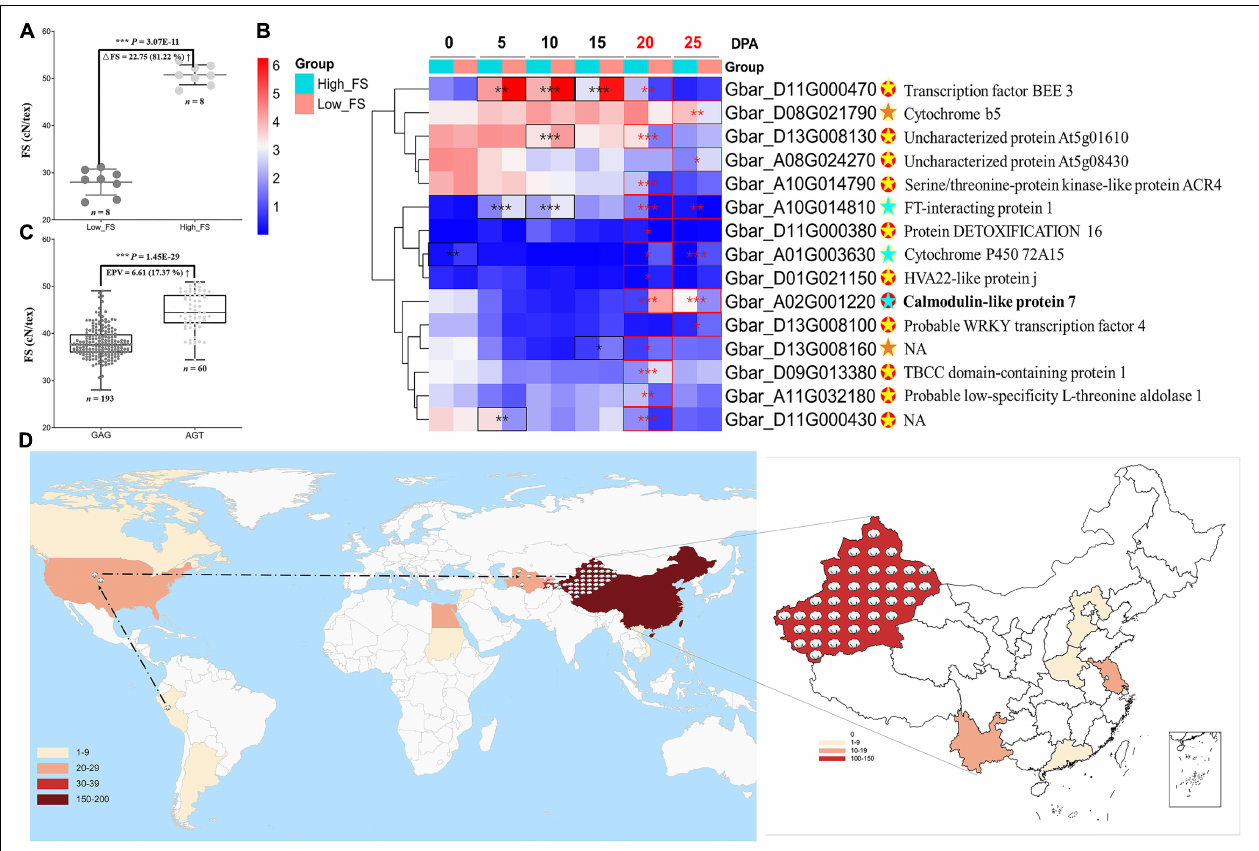
FIGURE 4 | Expression analysis on the fiber strength candidate gene and geographical distribution of elite haplotype of GbCML7 . (A) Phenotypic difference in fiber strength in FS extreme accessions used for expression analysis. Each solid point represents a set of original data. n = 8. The middle line represents the mean value, and the upper and the lower lines represent plus or minus standard deviation. High-FS and low-FS are the two FS extreme accessions, XH58 and Ashi, used for RNA-seq analysis. (B) Heatmap of 15 fiber-strength DEGs in 20 and 25 DPA fiber of FS extreme lines. The box color (from blue to red) represents –log 2 (FPKM + 1) value. The group in light blue and red represent accessions with high and low fiber strength, respectively. Eleven genes, marked with red solid spots, are hub genes. The remaining 4 genes are marked with yellow solid spots. Significance differences in gene expression between high and low fiber-strength accessions were analyzed with a two tailed t -test. *, **, *** indicates significant difference at P < 0.05, 0.01, 0.001, respectively. Significant differences at 20 and 25 DPA fiber are highlighted in red box. For hub genes with red spots, the light-yellow star denotes significant DEG at one stage, while the light blue denotes significance at two stages. For those genes with yellow spots, significant DEG in one stage is marked with an orange star. Gene annotations are on the far right. (C) Fiber strength in accessions with the two main haplotypes of GbCML7 ( Gbar_A02G001220 ). n represents the number of accessions with that specific haplotype. Each point represents one accession. Accessions with haplotype GAG are in dark gray, and those with haplotype AGT are in light gray. Boxes span the first to third quartiles, center lines represent median values, and whiskers show the minimum and maximum. (D) Geographical distribution of elite haplotype of GbCML7 . The color gradients in the lower left corner represent the numbers of Sea Island accessions from different countries we collected. Cotton icons indicate the locations of accessions with elite haplotype GbCML7. The dotted line marks the origin and domestication course of sea island